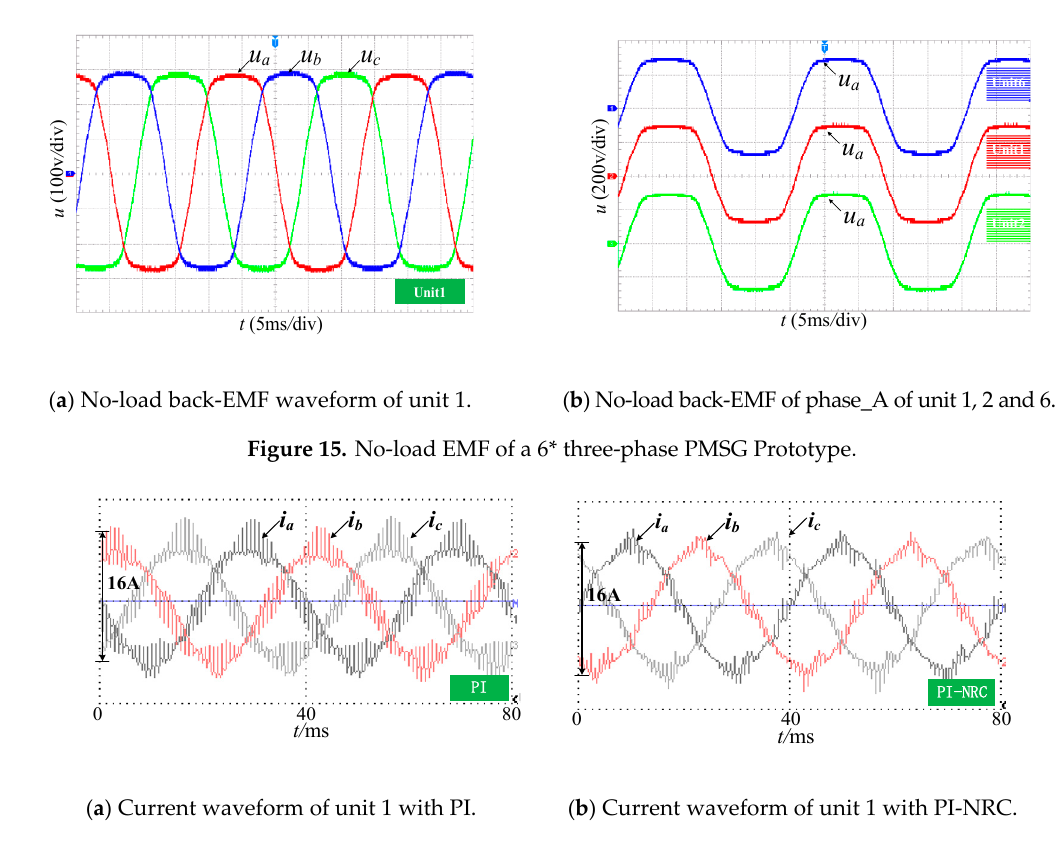
Figure 16. Current waveform of generator unit 1 with different controllers at 300 r/min.